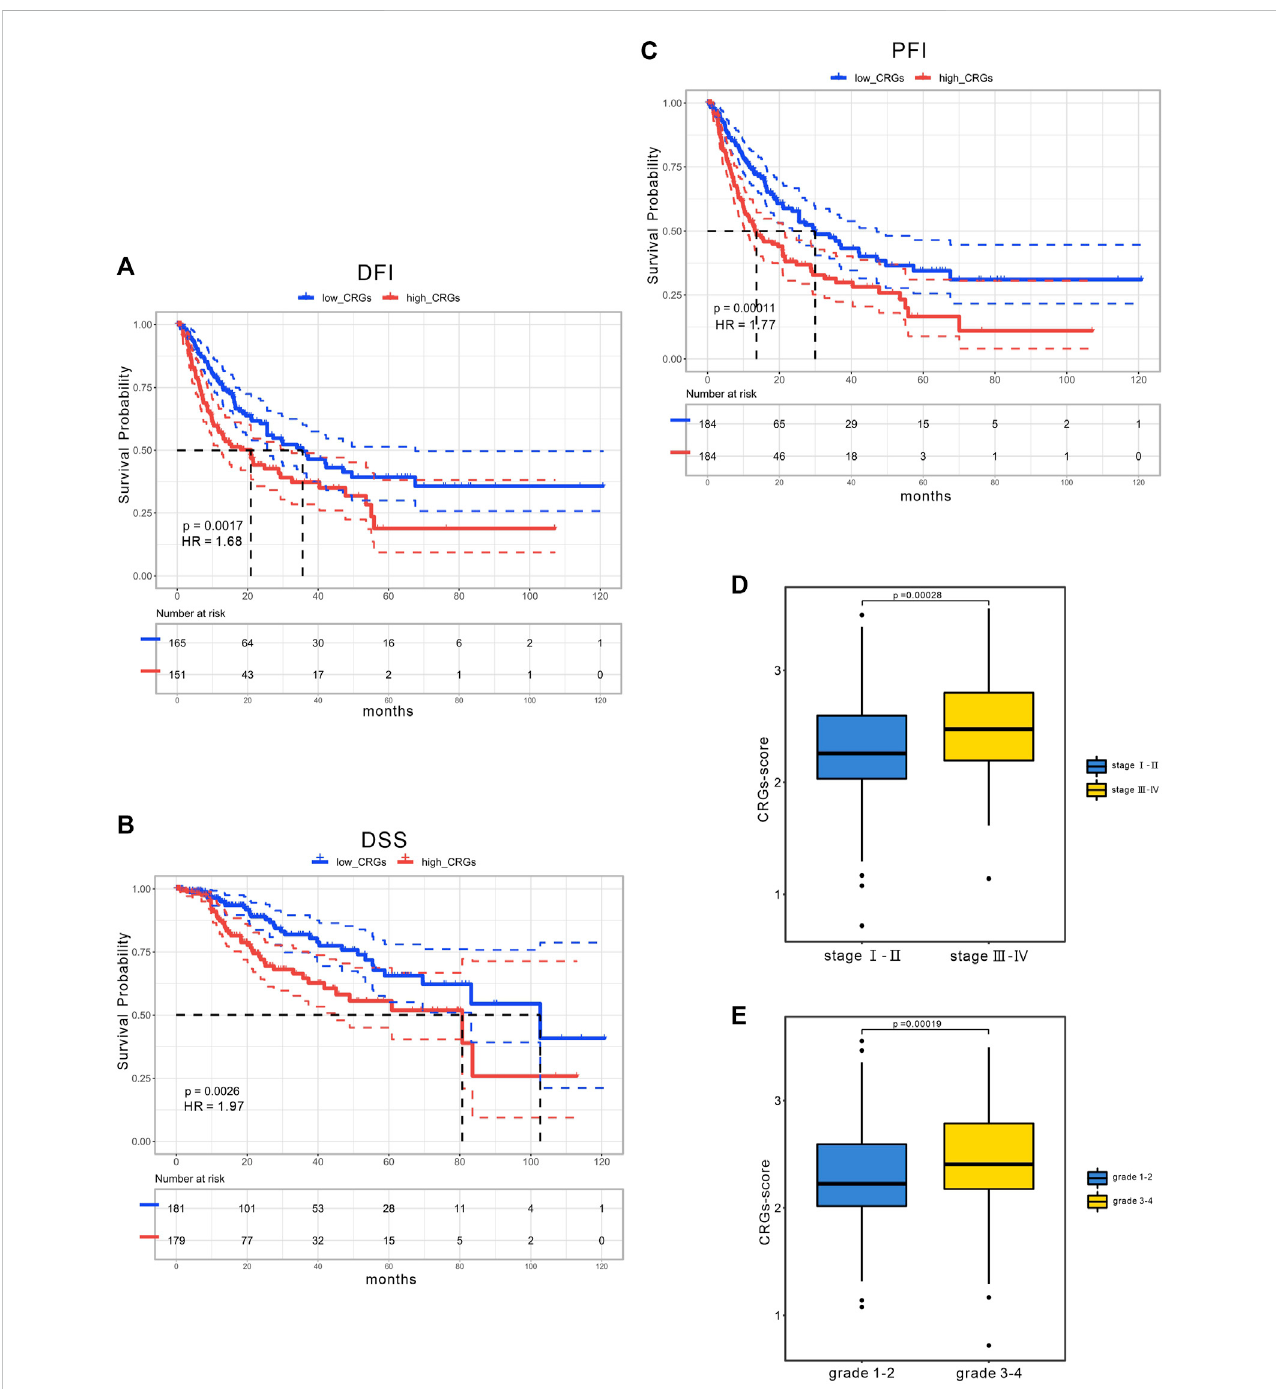
FIGURE 6 The clinical application of CRGs-score. The KM curves of (A) DFI (B) DSS (C) PFI time between low and high CRGs-score subgroups in the TCGA cohort. (D) CRGs-score between the early stage and the advanced stage subgroups. (E) CRGs-score between the low-grade and the high-grade